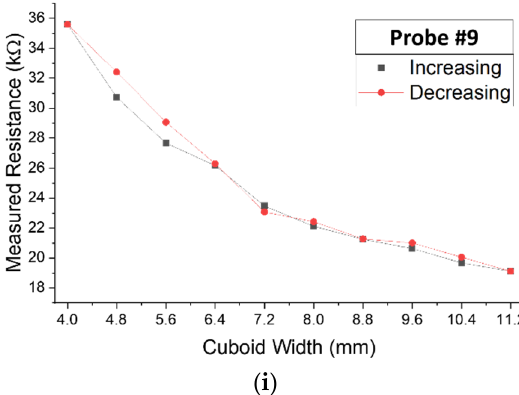
Figure 10. Hysteresis curves for 9 different probes showing the measured resistance while increasing and decreasing cuboid sizes: ( a ) Probe #1; ( b ) Probe #2; ( c ) Probe #3; ( d ) Probe #4; ( e ) Probe #5; ( f ) Probe #6; ( g ) Probe #7; ( h ) Probe #8; ( i ) Probe #9.